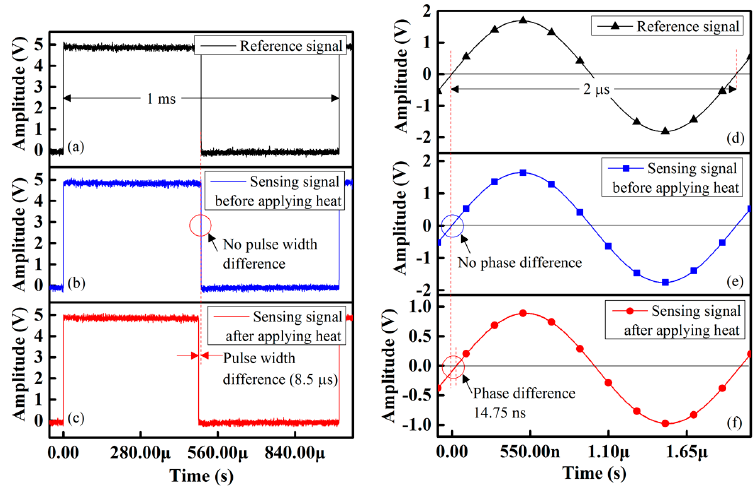
Figure 7. Waveform response of the proposed temperature sensors: ( a ) Reference signal of fiber-optic PWM sensing system; ( b ) Fiber-optic PWM sensing system before applying heat; ( c ) Fiber-optic PWM sensing system after recording heat response after applying heat; ( d ) Reference signal of IDC sensing system; ( e ) IDC sensing system before applying heat; and ( f ) IDC sensing system after applying heat.